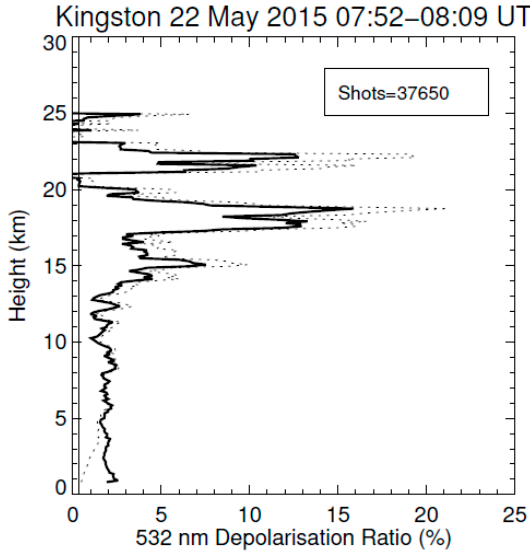
Figure 8. Mean profile of 532 nm linear volume depolarisation ratio δ v (z) for Kingston measurements on 22 May 2015 for heights 1–25 km. The depolarisation ratio was retrieved at 100 m vertical resolution and has been smoothed with a 5-point running mean. The solid vertical line marks the estimated linear depolarisation for molecular backscatter (0.37%) as discussed in Section 3.4. The thin dashed line shows the profile of the 1 σ uncertainty based on photon counting statistics and is shown on the same scale as the horizontal axis.